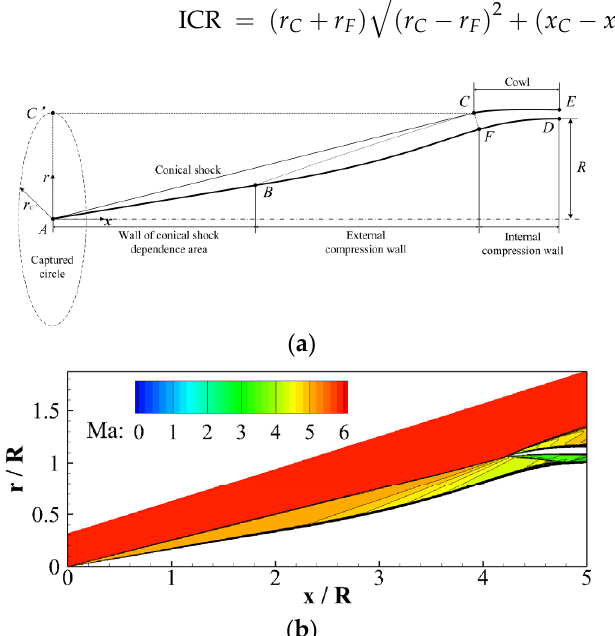
Figure 1. Studied model and Mach number contour under design point: ( a ) Schematic of the inlet configuration and flow structure; ( b ) Mach number contour.